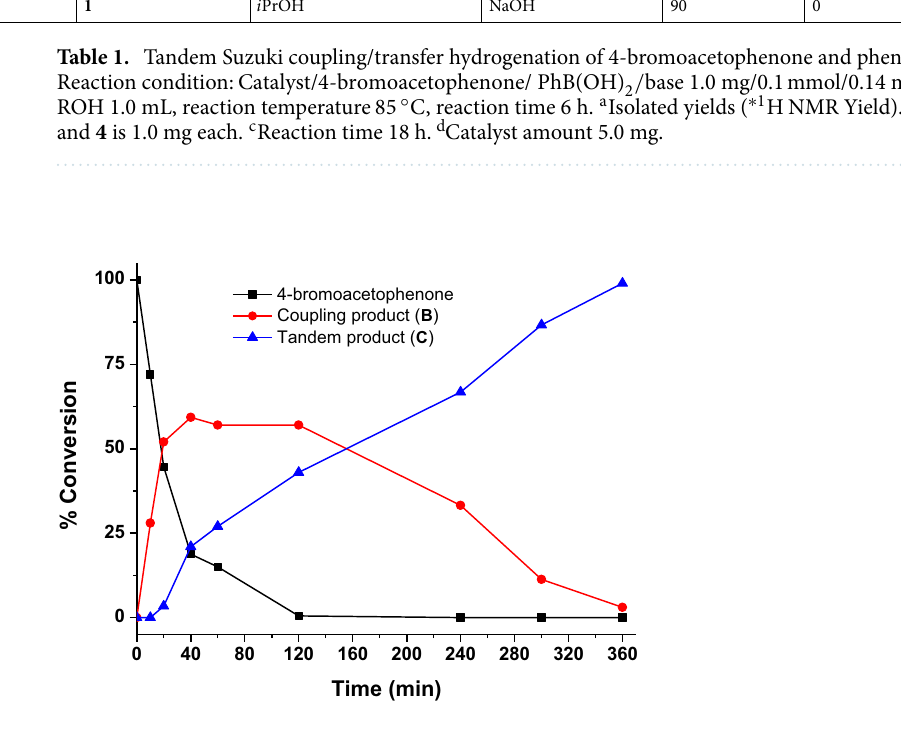
Figure 4. Reaction profile diagram for the tandem Suzuki coupling/transfer hydrogenation reaction catalyzed nanocomposite 5